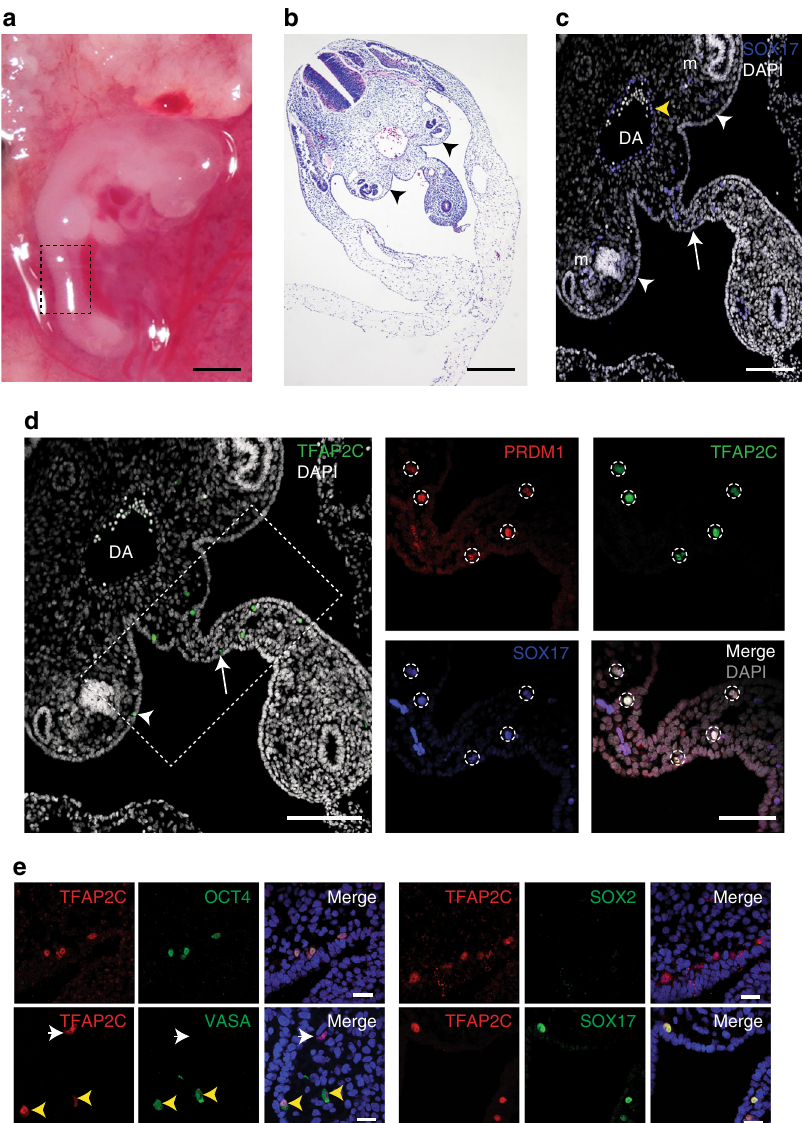
Fig. 1 Identi fi cation of rPGCs by immuno fl uorescence using early and late rPGC markers. a CS12 rhesus macaque embryo. Box highlights the region that was assessed for migrating rhesus Primordial Germ Cells (rPGCs) Scale bar, 1 mm. b Transverse histological section of CS12 embryo reveals the genital ridge epithelium (arrowheads) Scale bar, 400 µ m. c Immuno fl uorescence (IF) staining of CS12 sections showing SRY-box 17 (SOX17, blue) and DAPI nuclear stain (white) in genital ridge epithelium (white arrowheads), adjacent mesonephros (m) dorsal mesentery (white arrow), or hemogenic endothelium (yellow arrowhead) within the dorsal aorta (DA). Scale bar, 200 µ m. d IF staining of AP-2 gamma (TFAP2C, green) can discriminate rPGCs (box) in the dorsal mesentery (arrow) as well as the genital ridge epithelium (arrowhead) of a CS12 embryo. Triple IF staining of PR/SET domain 1 (PRDM1, red), SOX17 (blue), and TFAP2C (green) can be used to mark rPGCs (dotted circles) (merge, white; DAPI nuclear stain, gray). Scale bar, 200 µ m. e Dual IF for TFAP2C (red) con fi rms co-expression with the germ cell marker OCT4, SOX17, and VASA. Yellow arrow-heads indicate TFAP2C/VASA double positive rPGCs. White arrowheads indicate TFAP2C positive VASA negative rPGCs. SOX2 (green) is not expressed in rPGCs. Merged images show DAPI nuclear stain (blue). Scale bars, 15 µ m. n = 3 CS12 embryos, shown are images from Day (D)